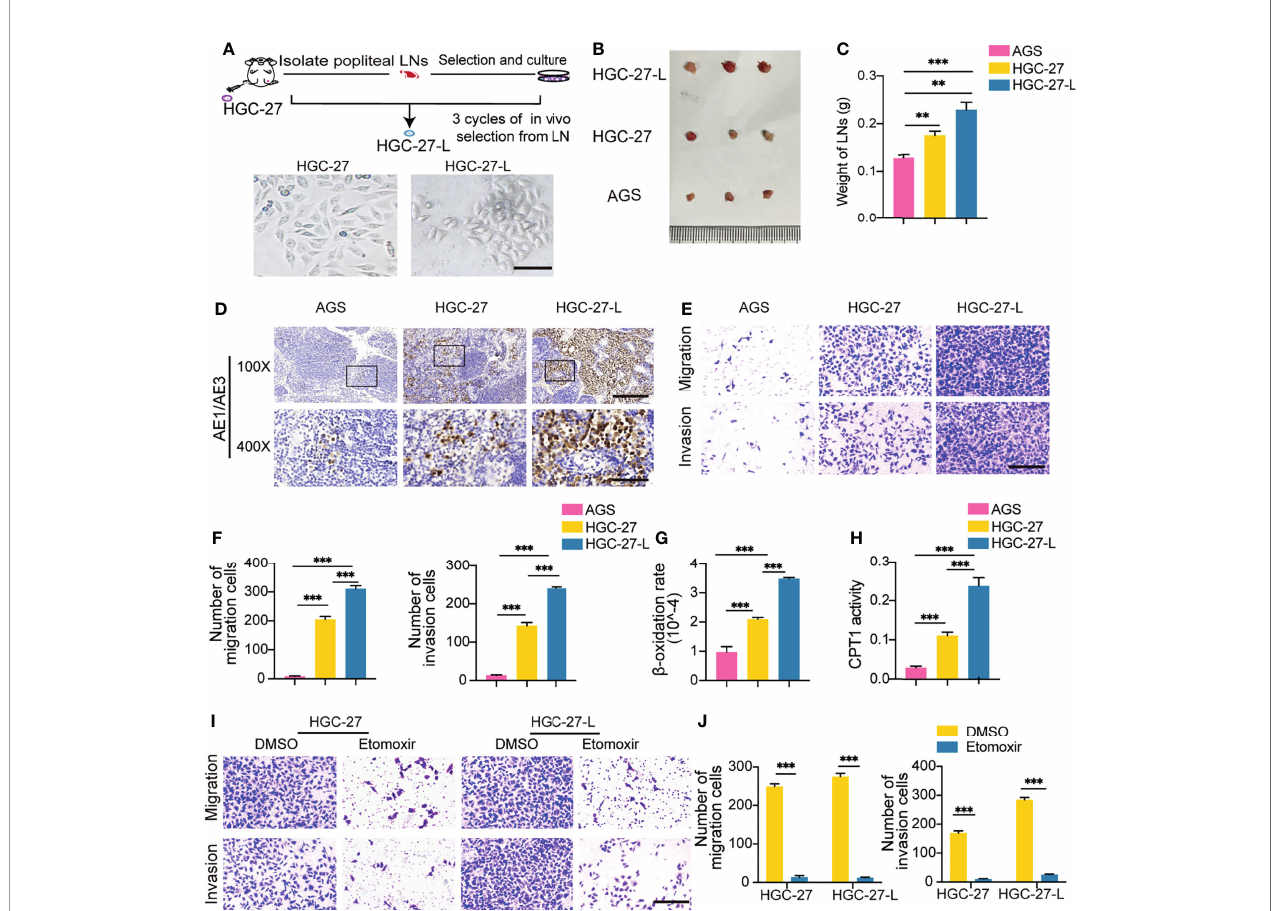
FIGURE 1 | Establishment of a highly lymphatic metastatic GC cell line HGC-27-L and lymphatic metastatic GC cells sustained LNM capacity depending on FAO (A) A fl ow chart illustrates the establishment of HGC-27-L by serial transplantation of parental cell HGC-27 in vivo . Images of cell morphology are presented. (magni fi cation, 400×; scale bars, 50 m m); (B – D) In vivo comparison of LNM capacity among AGS, HGC-27 and HGC-27-L by popliteal LNs analysis. (B) Pictures of LNs. Ruler unit, mm; (C) Weight of LNs; (D) Pancytokeratin AE1/AE3 staining (magni fi cation, 100×; scale bars, 200 m m; magni fi cation, 400×; scale bars, 50 m m); (E, F) In vitro comparison of migration and invasion capacity among the three cell lines. (E) Morphology of migrated and invaded cells (magni fi cation, 200×; scale bars, 100 m m); (F) Count of migrated and invaded cells; (G) b -oxidation rate detection; (H) CPT1 activity analysis; (I, J) Effect of etomoxir treatment on migration and invasion capacity of HGC-27 and HGC-27-L cells. (I) Morphology of migrated and invaded cells (magni fi cation, 200×; scale bars, 100 m m); (J) Number of migrated and invaded cells. ** P < 0.01; *** P <